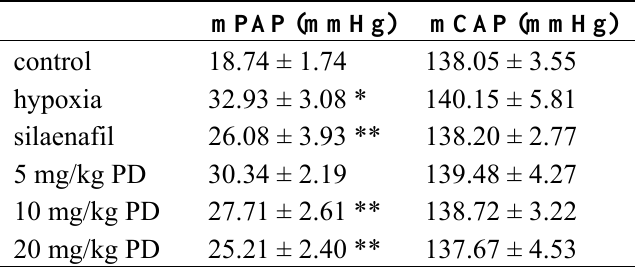
Table 1. Effects of polydatin on mean pulmonary arterial pressure (mPAP) and mean carotid ** p < 0.05 vs.